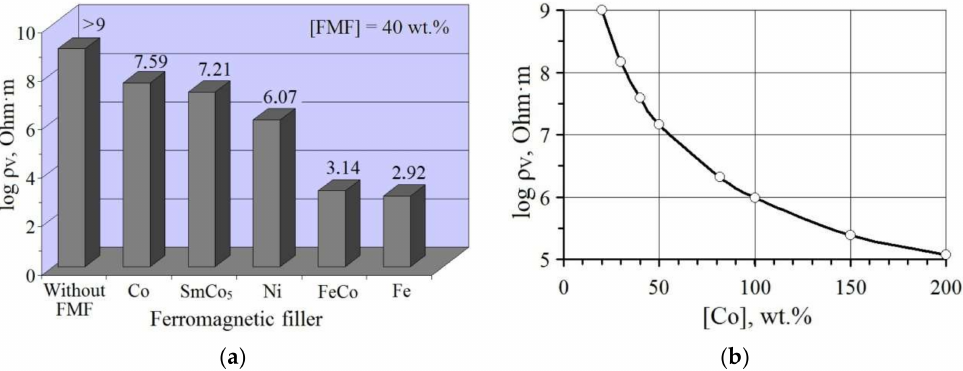
Figure 12. The effect of nature ( a ) and content ( b ) of FMF on electrically conductive characteristics of dry FMF/pHEMA-gr-PVP composites (HEMA:PVP = 70:30 mass